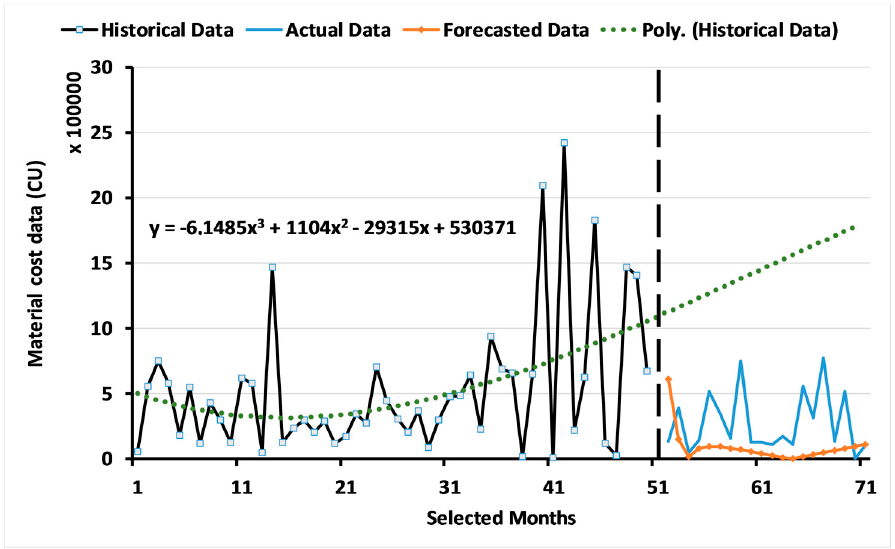
Figure 5. Material cost data forecasting using the multi ‐ objective GA based on the ARIMA model.